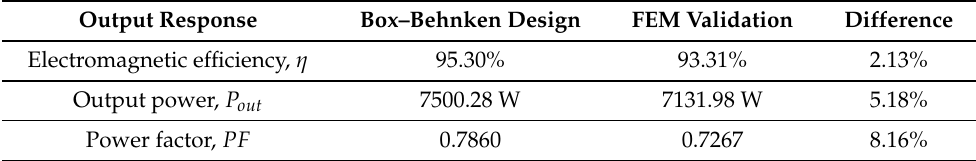
Table 4. FEM validation of the optimal solution from Box–Behnken design